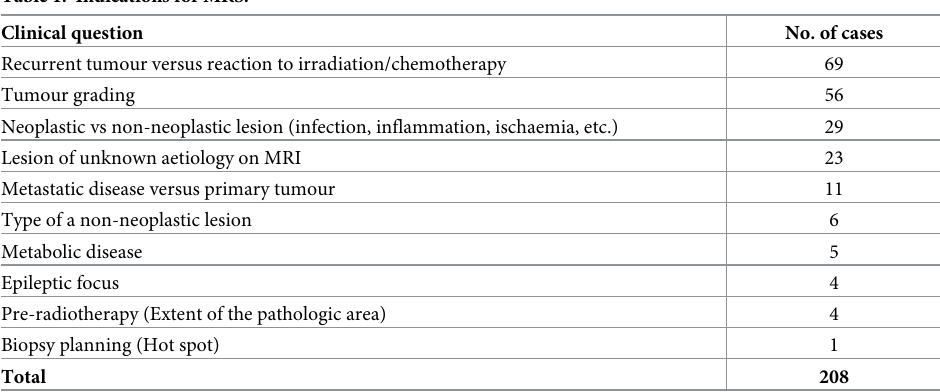
Table 1. Indications for